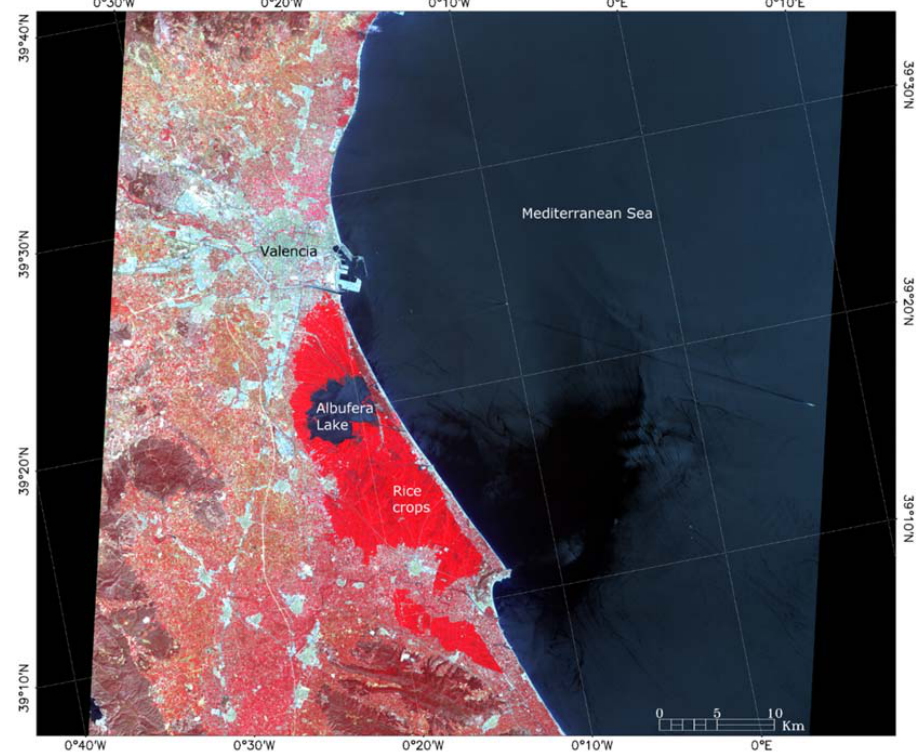
Figure 1. Scene over the study area on 3 August 2004 using VNIR ASTER Channels 3n (0.81 µm), 2 (0.66 µm) and 1 (0.56 µm) to compose the RGB image, respectively.